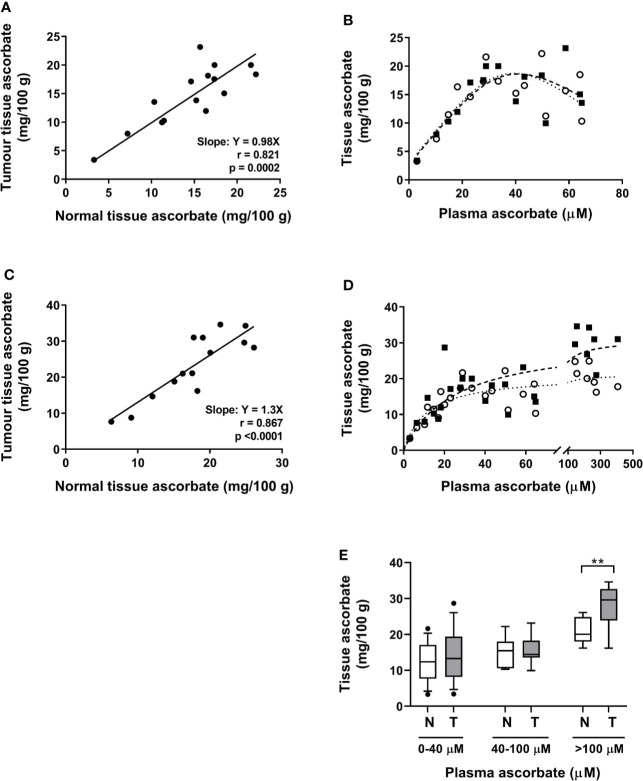
Associations between tumor and normal tissue ascorbate, and between tissue and plasma ascorbate levels in patients with colon cancer. (A) At biopsy, tumor and normal mucosa tissue ascorbate is closely correlated (Pearson r = 0.82, p = 0.0002). (B) Association between plasma ascorbate levels and normal mucosa (○) and tumor (▪) tissue in patients at biopsy (least squares fit, R2 for best fit 0.64 and 0.62 for normal (…….) and tumor (—), respectively). (C) At resection, a correlation between tumor periphery and normal tissue is seen (Pearson r = 0.87, p < 0.0001). (D) Association between plasma levels (pre-infusion on day prior to resection) and normal mucosa (○) and tumor periphery (▪), with non-linear saturation curve fit indicated (R2 for best fit 0.85 and 0.69 for normal and tumor, respectively). Individual data for control (n = 6) and infusion cohorts (n = 9). (E) Comparison of normal mucosa (N) and tumor (T) tissue ascorbate levels with increasing plasma levels. Box plots show medians and the interquartile range with whiskers representing the 10–90 percentiles. There is a significant difference between mucosal and tumor tissue when plasma levels exceed the normal physiological maximum of 100 µM (unpaired t-test, **p = 0.008).